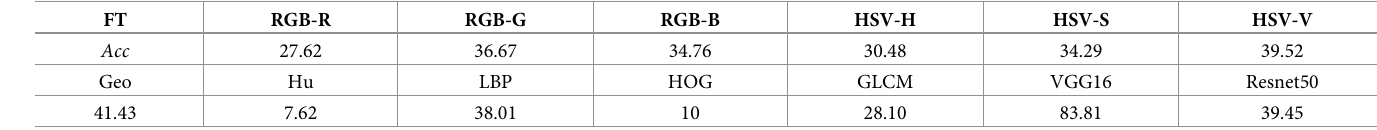
Table 10. Classification accuracy of single-object features by RBFSVM using EMDS-5. Feature type (FT), Accuracy (Acc), Geometric features (Geo), Hu moments (Hu). (In [%].). FT